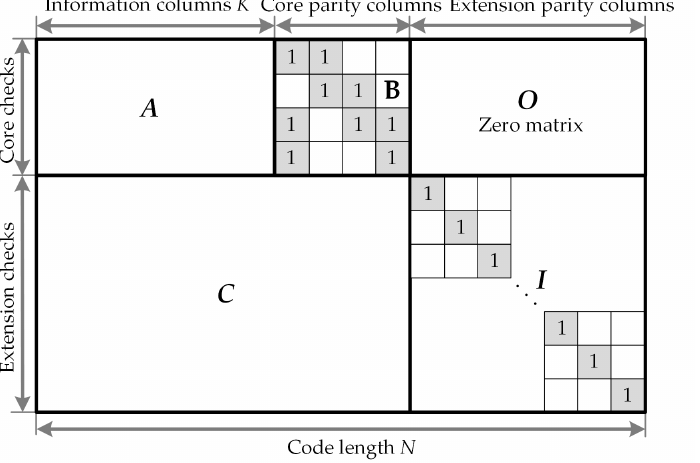
Figure 1. Sketch of base parity-check structure for the 5G new radio (NR) quasi-cyclic low-density parity-check (QC-LDPC) codes.